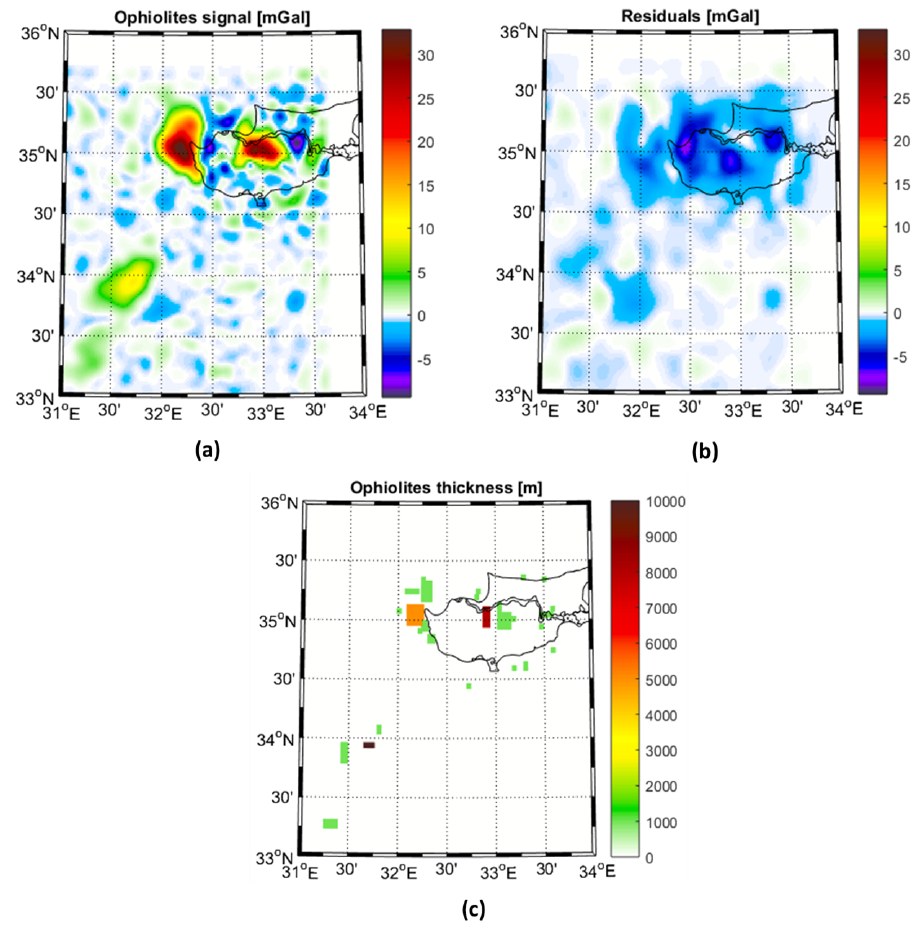
Figure 5. The isolated signal due to the presence of ophiolites ( a ), residuals after the modeling ( b ) thickness and position of the main ophiolite structures as estimated in the inversion ( c